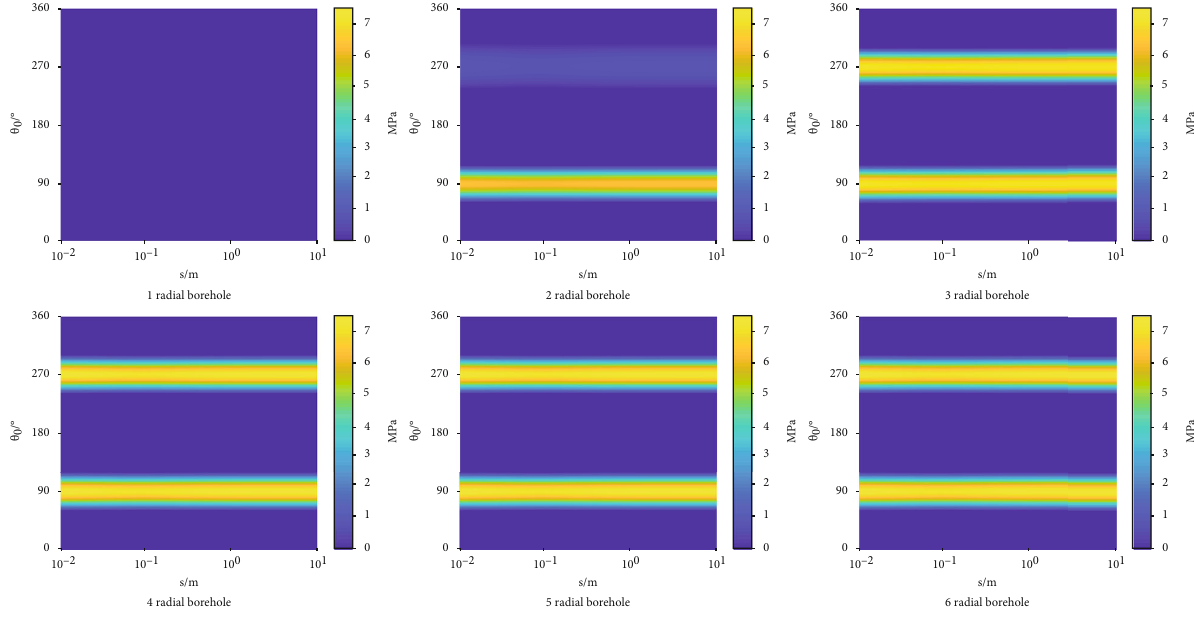
Figure 21: Maximum tensile stress increasing region with di ff erent radial borehole number.